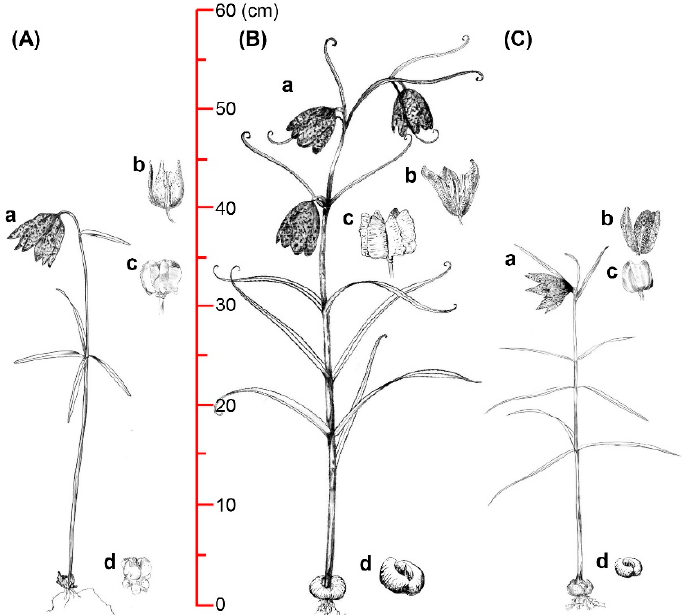
Figure 4. The morphological ideograms of the representative Fritillaria species in three altitude groups. ( A ). The morphological features of F. maximowiczii Freyn growing distributed between 1500–2700 m in Group 2. a. The plant of F. maximowiczii . b. The flower of F. maximowiczii . c. The capsule of F. maximowiczii . d. The bulb of F. maximowiczii . ( B ). The morphological features of F. thunbergii growing below 1500 m in Group 3. a. The plant of F. thunbergii . b. The flower of F. thunbergii . c. The capsule of F. thunbergii . d. The bulb of F. thunbergii . ( C ). The morphological features of F. cirrhosae growing between 2700–4000 m in Group 1. a. The plant of F. cirrhosae . b. The flower of F. cirrhosae . c. The capsule of F. cirrhosae . d. The bulb of F. cirrhosae